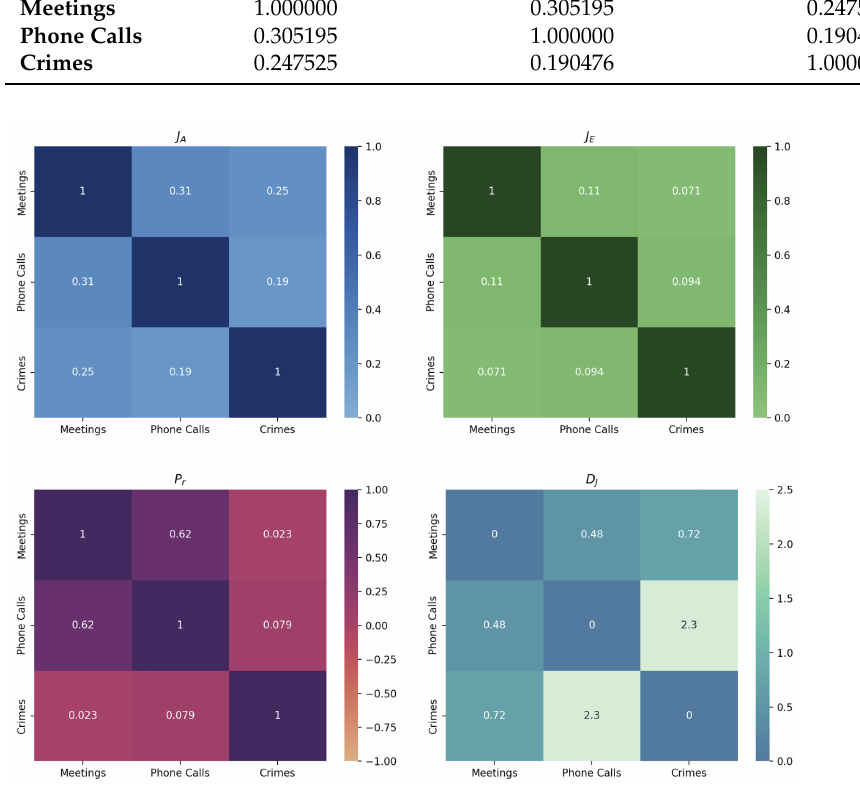
Table 5. Jaccard overlapping of the actors in the Montagna multiplex network